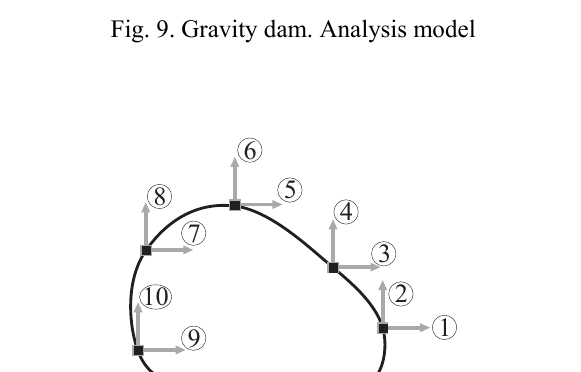
Fig. 9. Gravity dam. Analysis model